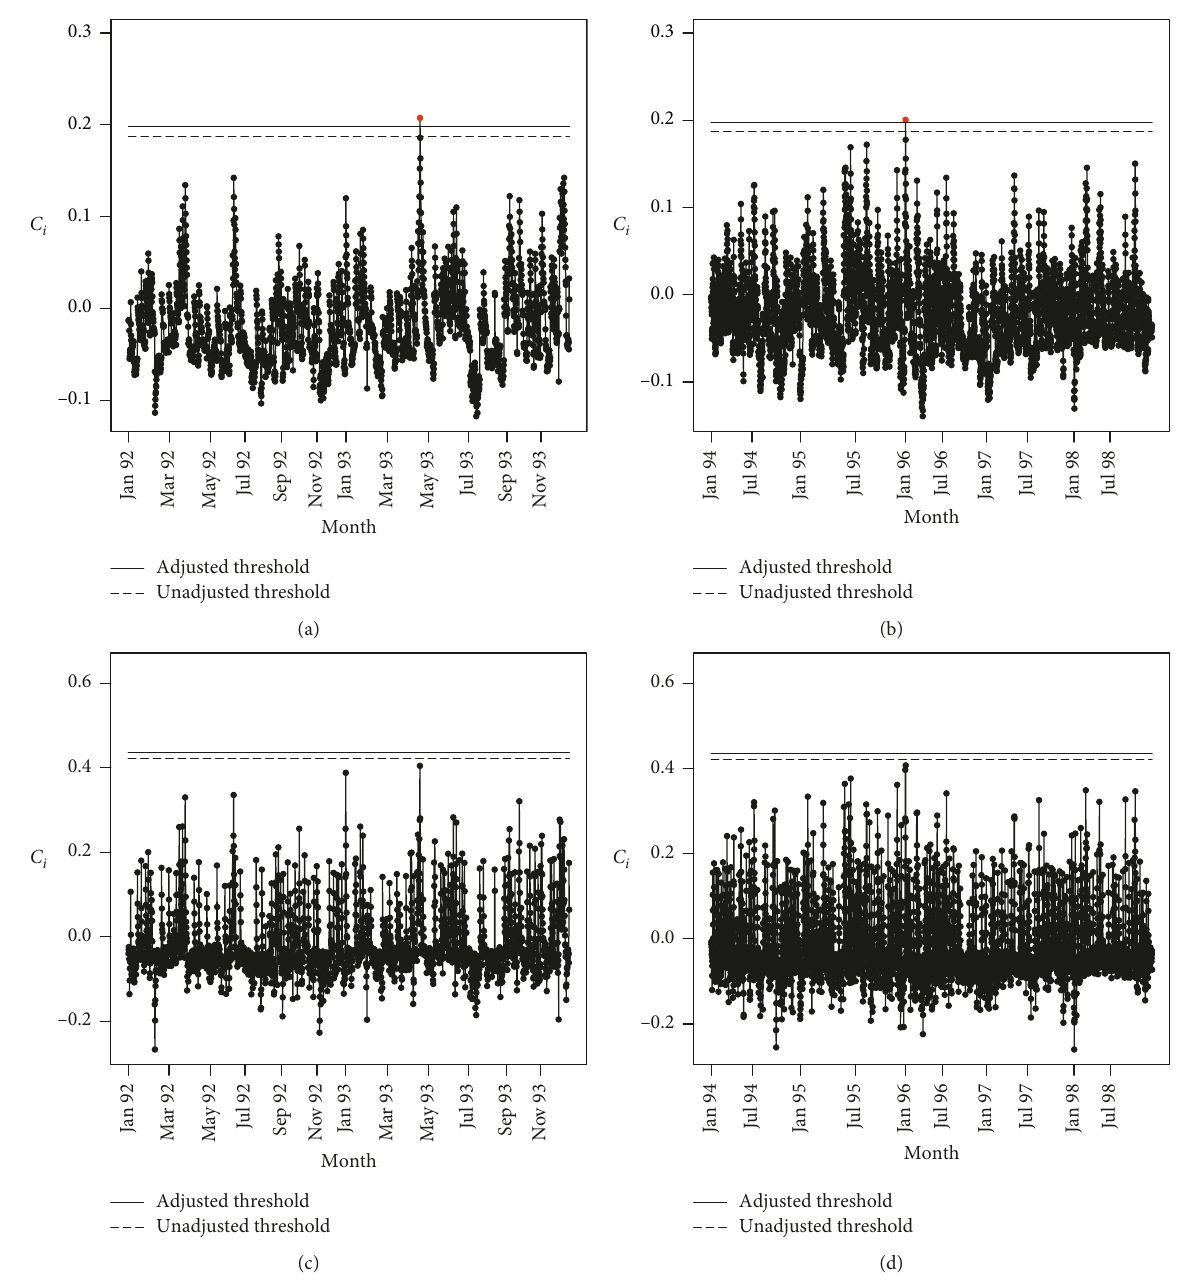
Figure 14: RA-EWMA chart for Phase-I and Phase-II assuming first two years as the Phase-I for 30 days mortality of cardiac surgery patients. (a) Phase-I chart, unadjusted UCL � 0.1871 and adjusted UCL � 0.198 and λ � 0.1. (b) Phase-II chart, unadjusted UCL � 0.1871 and adjusted UCL � 0.198 and λ � 0.1. (c) Phase-I chart, unadjusted UCL � 0.4213 and adjusted UCL � 0.4361 and λ � 0.3. (d) Phase-II chart, unadjusted UCL � 0.4213 and adjusted UCL � 0.4361 and λ �